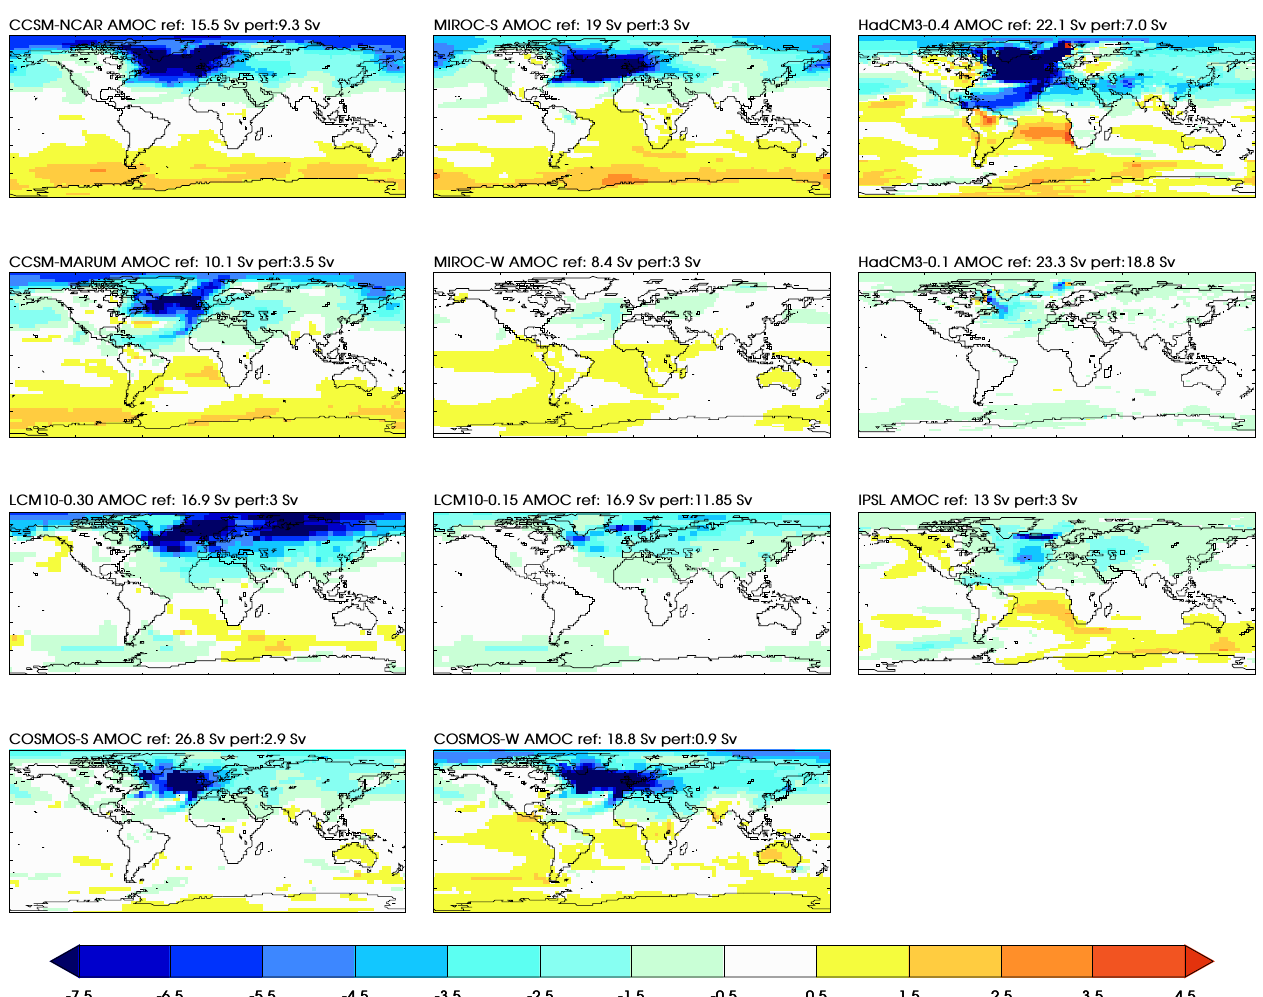
Fig. 2. Mean annual surface air temperature response (hosing experiment – reference experiment, in K) to fresh water hosing in the 11 hosing